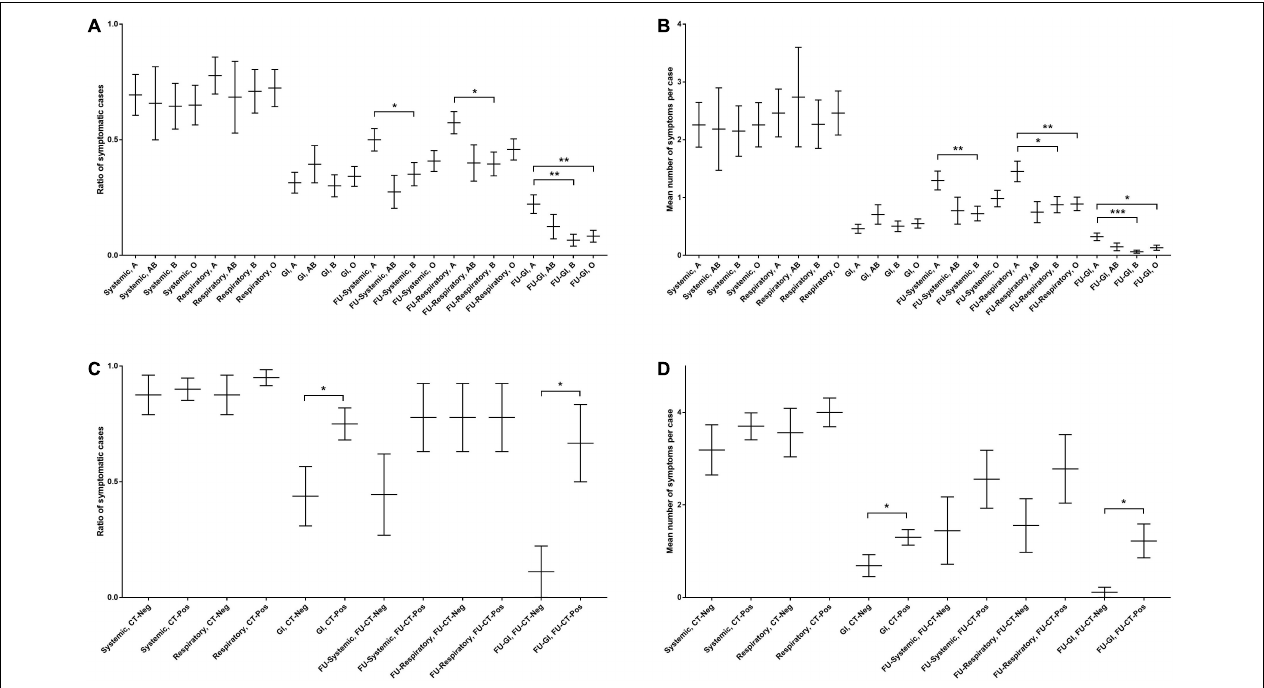
FIGURE 3 | Association of the systemic, respiratory, and GI symptoms at the baseline and after 3-month FU with ABO blood groups and chest computed tomography (CT)-scanning. (A) The ratio of symptomatic cases with certain ABO blood groups. (B) The mean number of symptomatic cases with particular ABO blood groups. (C) The ratio of symptomatic cases with and without a positive lung CT-scanning. (D) The mean number of symptomatic cases with and without a positive lung CT-scanning. (CT: computed tomography, FU: follow-up, and GI: gastrointestinal). *unpaired two-tailed Student’s t -test, P < 0.05. **unpaired two-tailed Student’s t -test, P < 0.01. ***unpaired two-tailed Student’s t -test, P <